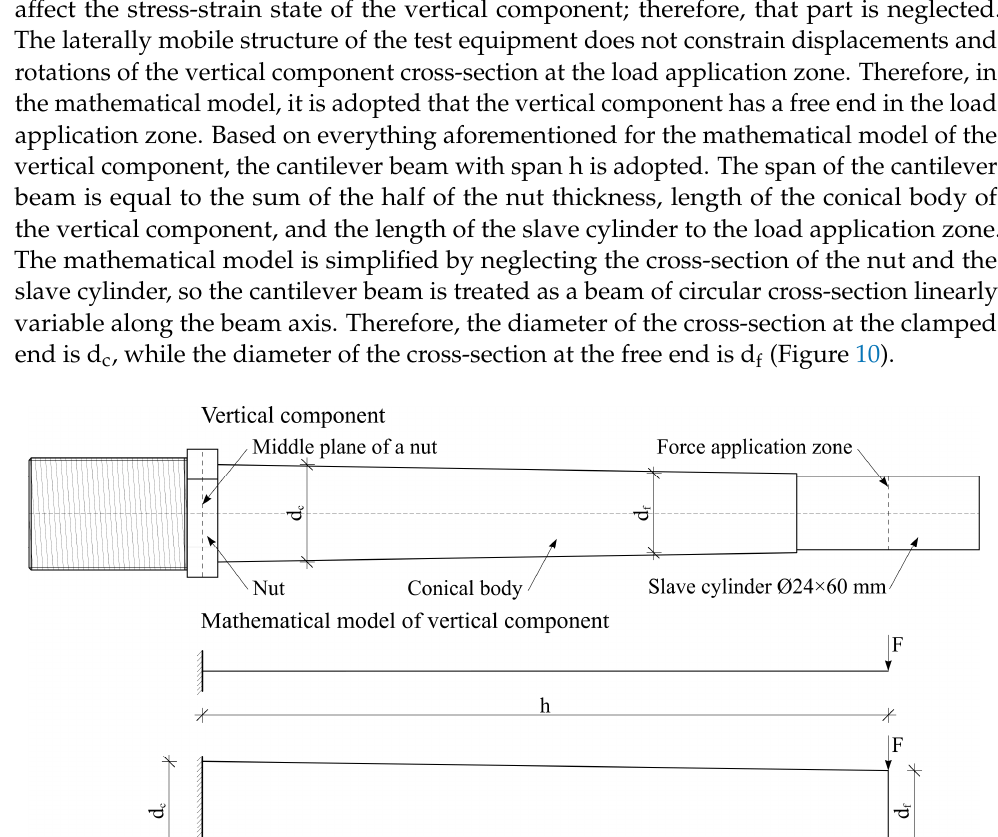
Figure 9. A force–displacement diagram for VC2.